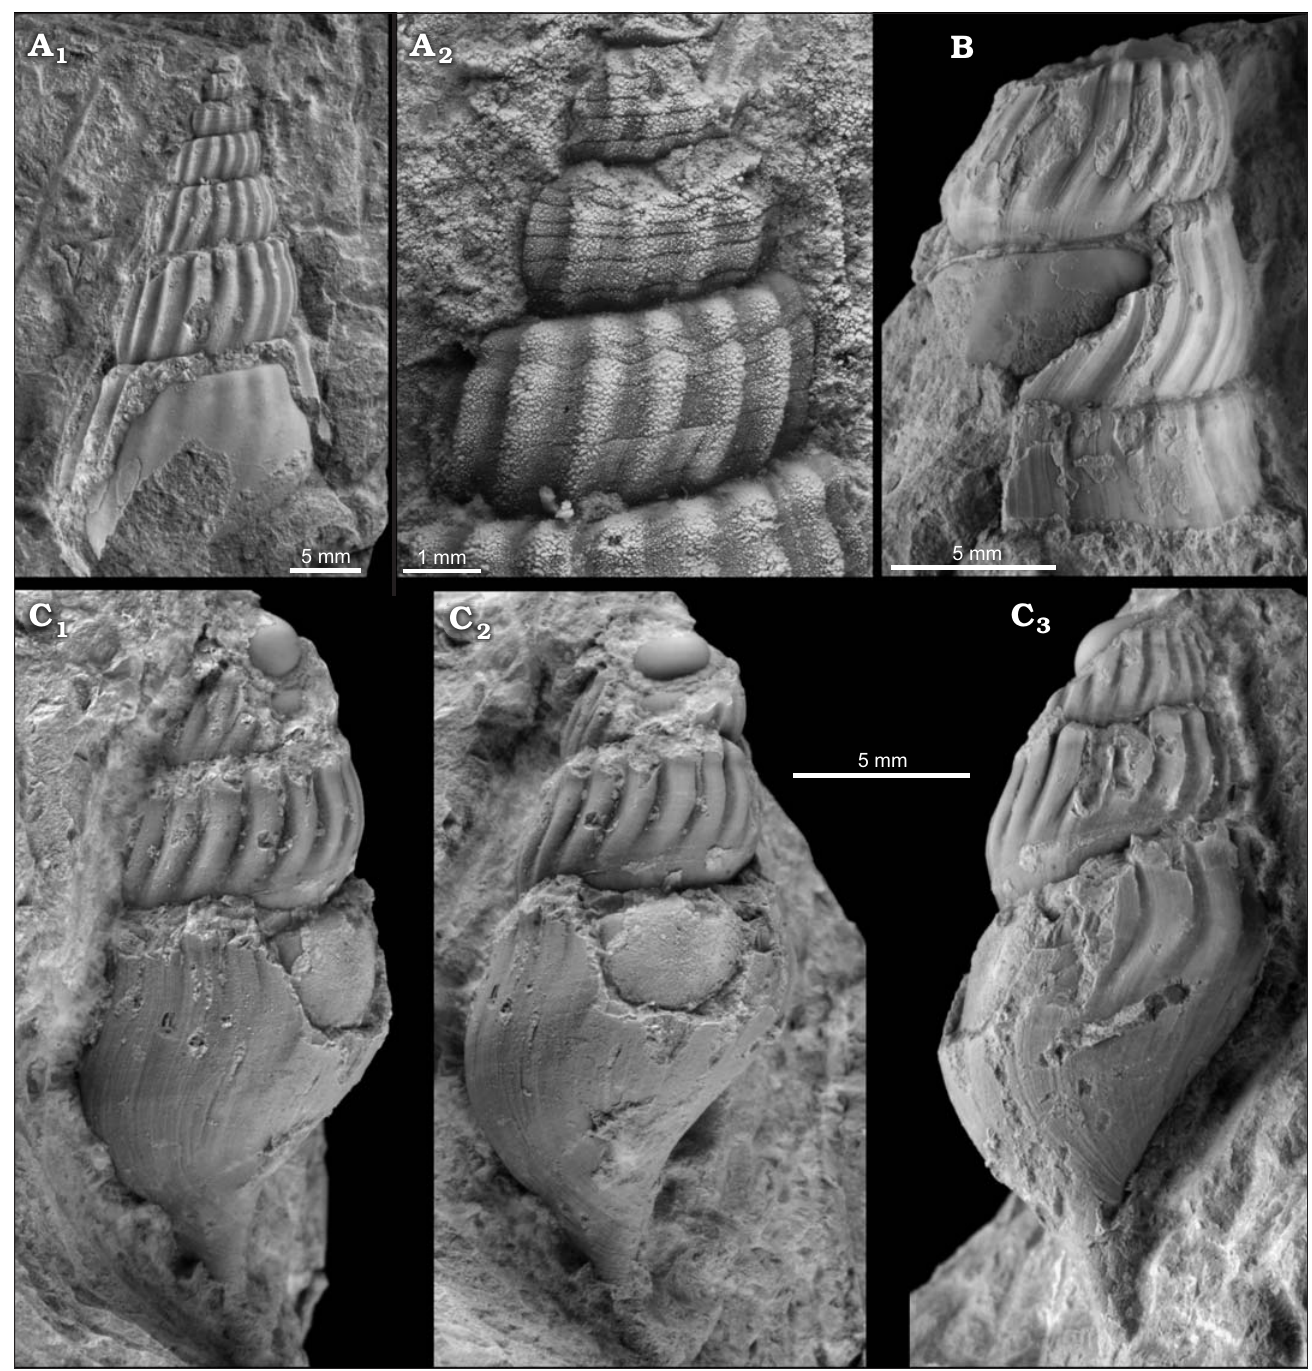
Fig. 16. The hokkaidoconchid gastropod Ascheria salina sp. nov. from early Oligocene seep deposits at Cerro La Salina (block 1, B, C; block 2, A) Talara Basin, northern Peru. A . Paratype (NRM Mo187059) showing fine spiral sculpture on early whorls (A 2 , close-up of the apical part). B . Paratype (NRM Mo187060) large fragmentary specimen. C . Holotype (NRM Mo187061) showing opisthocline axial ornament and faint spirals on last whorl (C 1 –C 3 , different lateral views). All in lateral → Fig. 15. The provannid gastropod Provanna pelada sp. nov. from the early Oligocene seep deposit at Cerros El Pelado block 3, Talara Basin, northern Peru. A . Holotype (NRM Mo187052), smooth specimen in apertural (A 1 ) and abapertural (A 2 ) views. B . Paratype (NRM Mo187053), specimen with faint spiral ornament, in apertural view. C . Paratype (NRM Mo187054), specimen with axial and spiral sculpture, in two lateral views (C 1 , C 2 ). D . Paratype (NRM Mo187055), nearly smooth specimen with faint spirals. E . Paratype (NRM Mo187056), showing distinctive prosocline growth increments and basal con- striction. F . Paratype (NRM Mo187057), smooth specimen. G . Paratype (NRM Mo187058), specimen with rough, irregular prosocline ribs and fine spiral sculpture. All in lateral view, unless otherwise indicated.